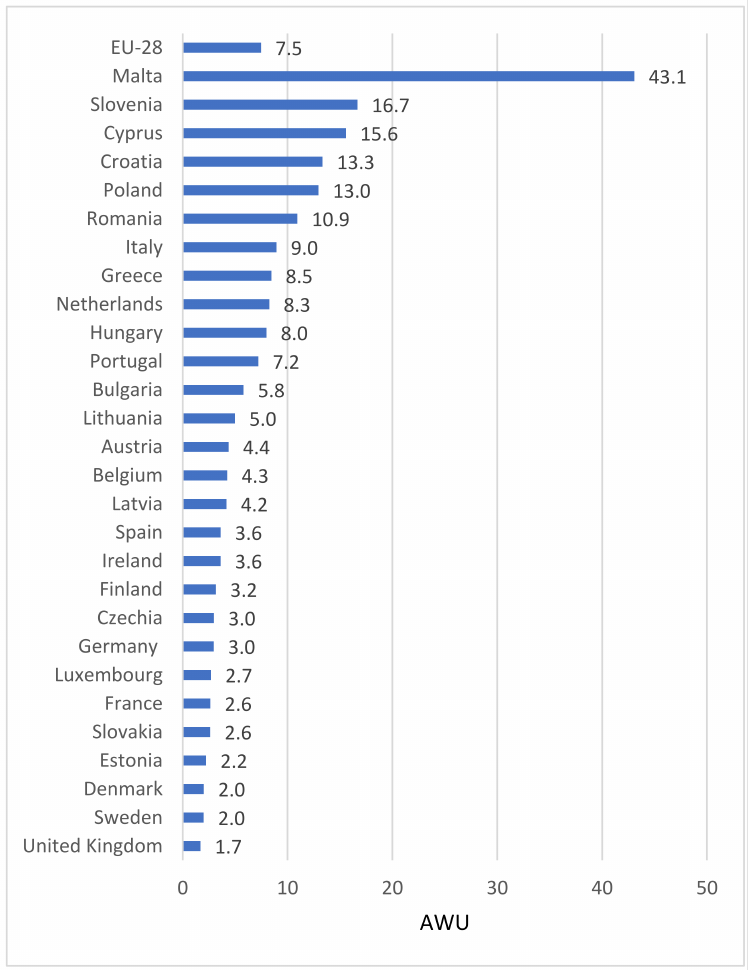
Figure 4. The number of full-time equivalents in agriculture per 100 ha of UAA in the member states of the EU from 2010 to 2019 (AWU per 100 ha of UAA). Table 3. Assessment of the significance of differences between EU-15 and EU-13 groups (Mann- Whitney test